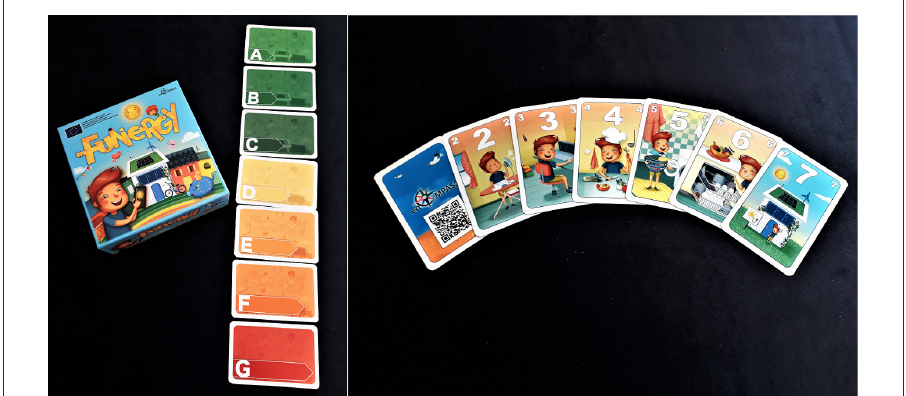
Figure 1: Left: European Energy Scale Cards, Right: Playing